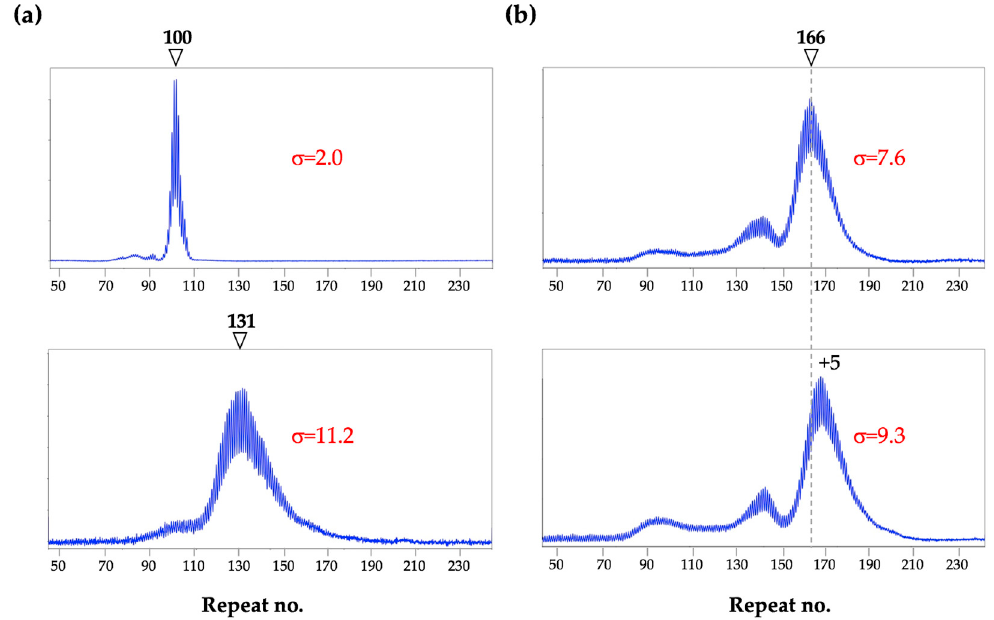
Figure 3. Blood repeat PCR profiles for 3 human male PM carriers. Repeat PCR analysis was carried out as described previously [31]. The number associated with each arrowhead represents the number of repeats in the indicated allele. ( a ) Profiles of two individuals showing a unimodal profile with a sharp peak (top) and a broad peak (bottom); ( b ) Profiles generated from the same individual using samples taken 4 years apart. The dotted line in these panels indicates the size of the major allele at the earlier timepoint. A shift corresponding to the gain of 5 CGG repeats is seen in the later sample. In each case the σ values are for the major allele peak .